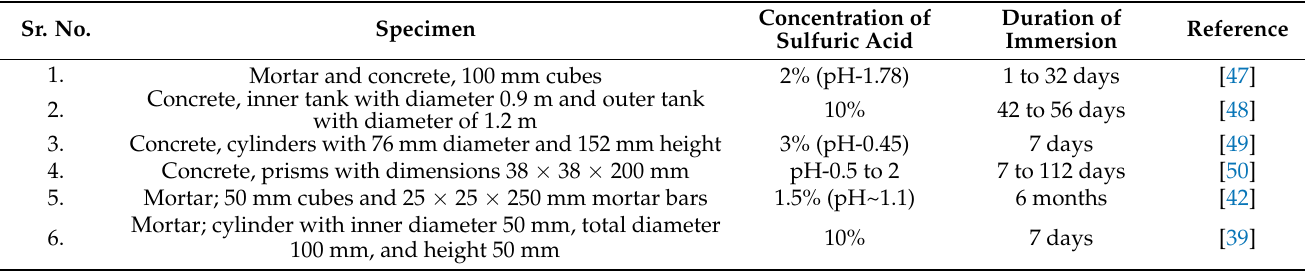
Table 1. Summary of chemical tests performed in various studies.